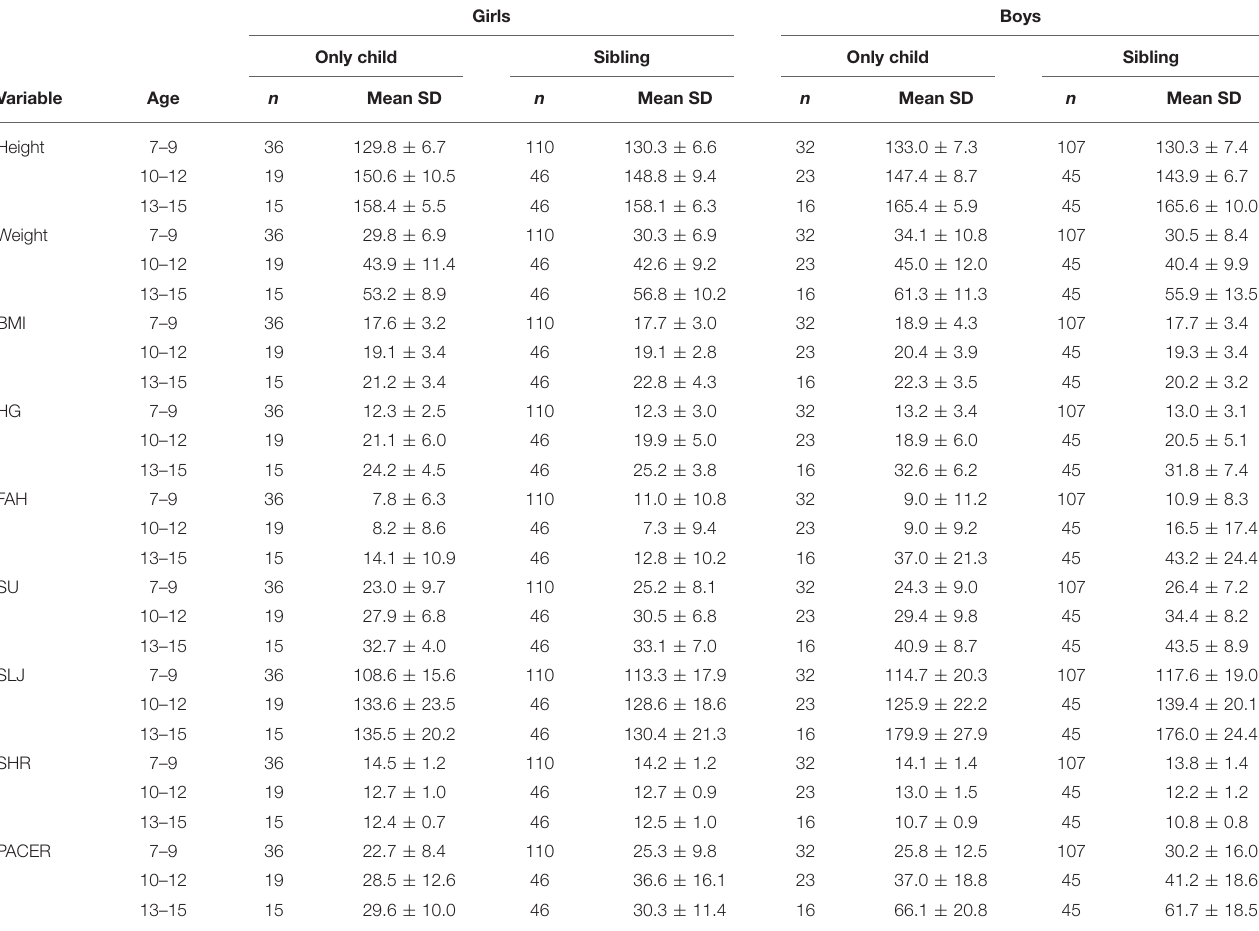
TABLE 1 | Number of subjects, mean, and standard deviation values for all variables according to age group, sex, and the existence of siblings in the family.